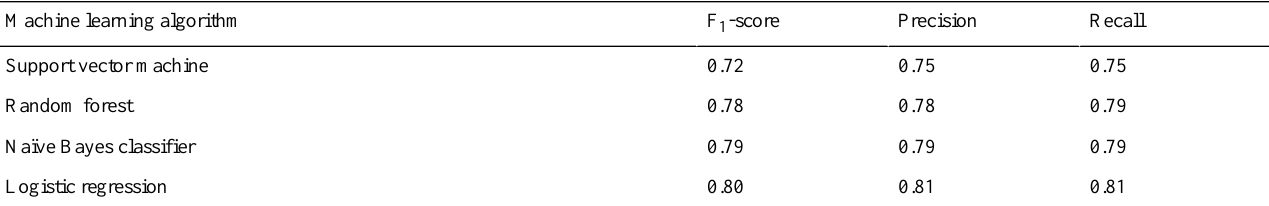
Table 2. Precision, recall, and F 1 -score for the relevance machine learning algorithms with optimal performance on logistic regression analysis.